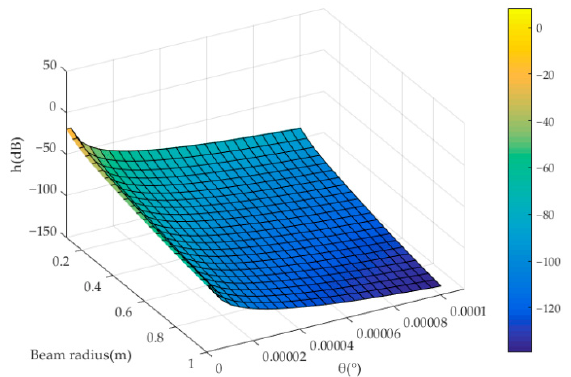
Figure 8. The relationship between pointing error angle, beam radius at the transmitting end, and signal power attenuation.